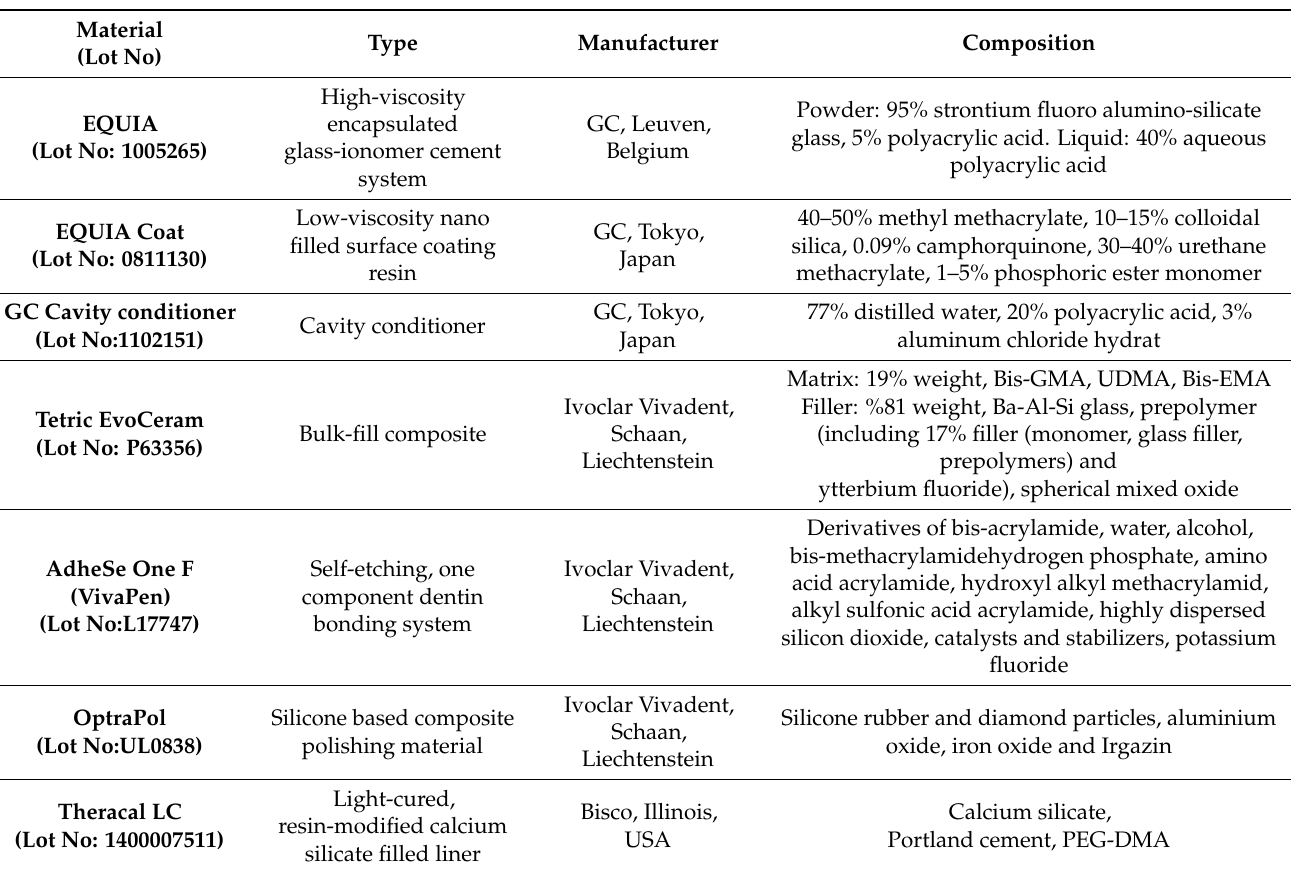
Table 1. Description of materials used in this study.